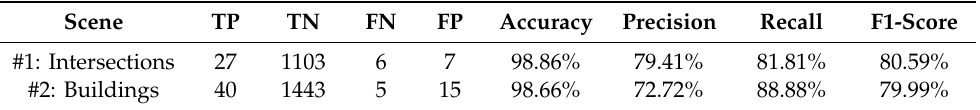
Table 5. Actual scene experiment results.